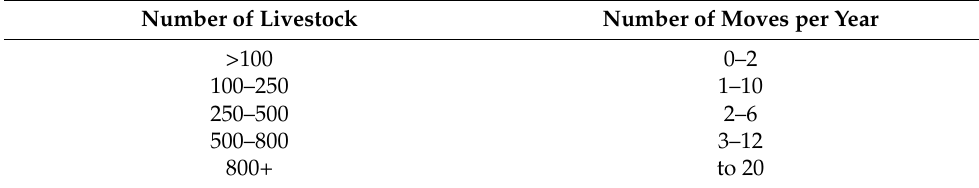
Table 4. Number of herder moves per year by number of livestock.